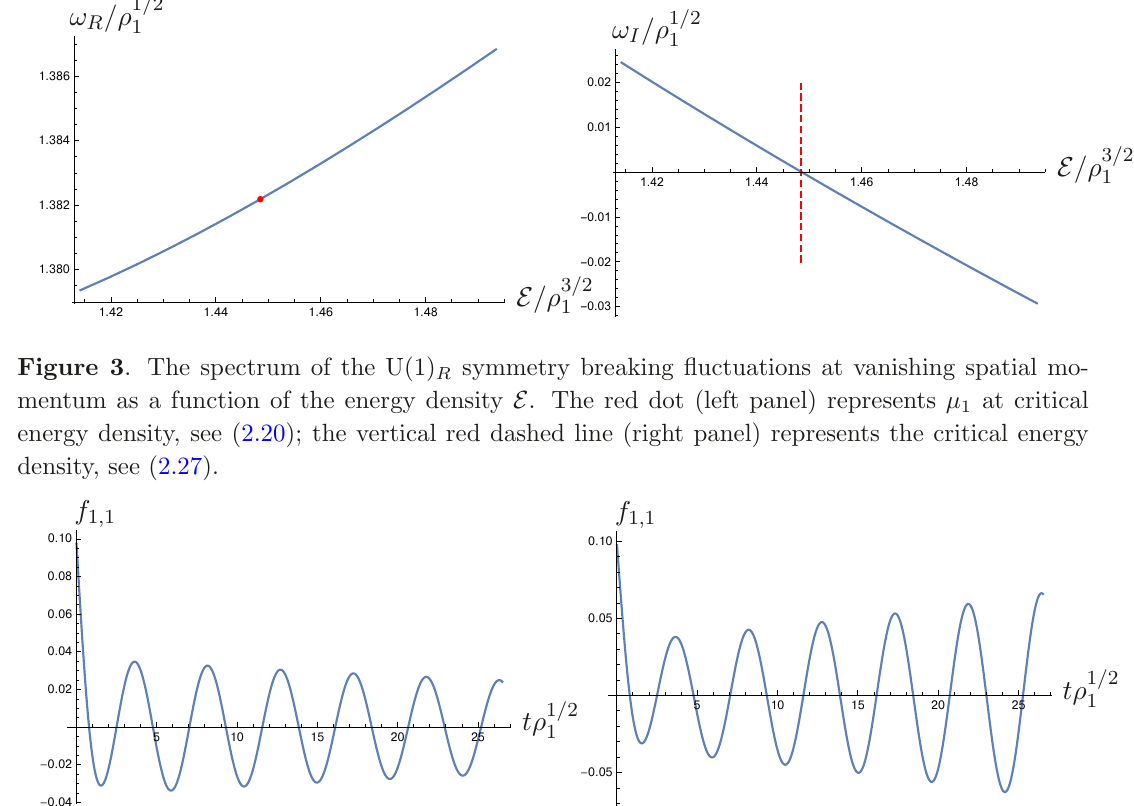
Figure 4 . Linearized dynamics of the symmetry breaking scalars f i ( t, x ) on RN black brane background is captured by the evolution of the expectation value f 1 , 1 ( t ), see (2.33). Left panel corresponds to dynamics at energy density panel describes spontaneous symmetry breaking at